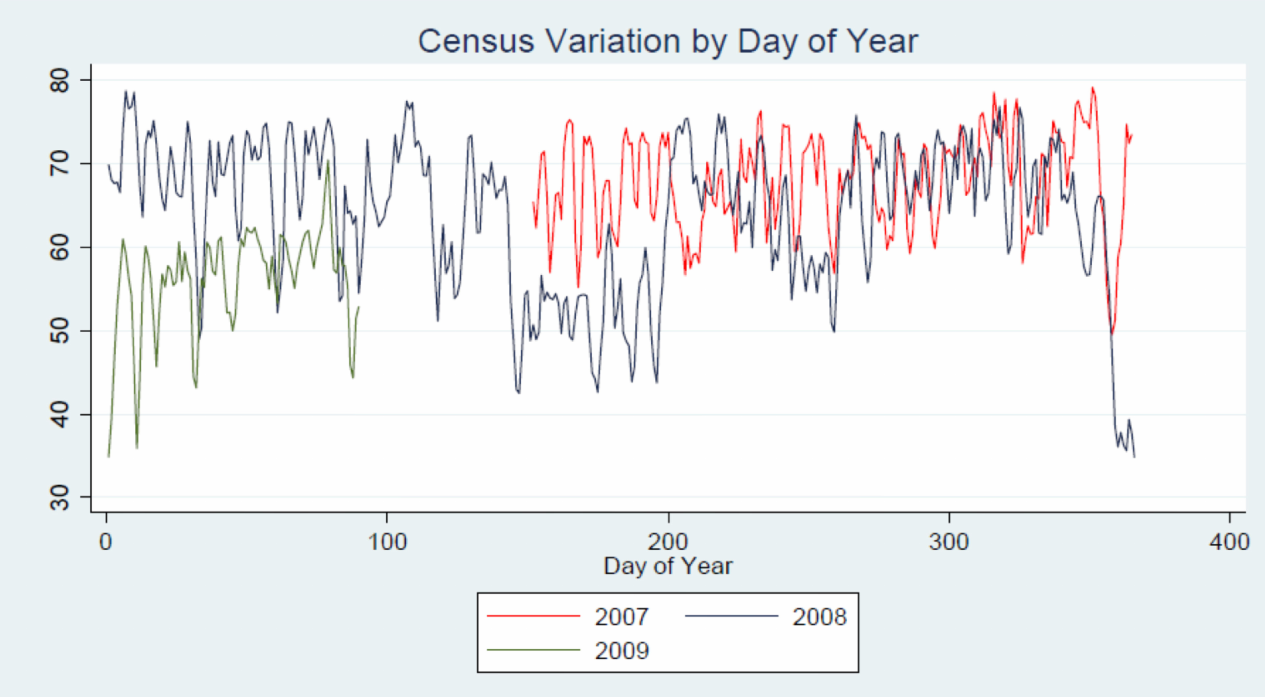
Figure 6. Census fluctuations across four partially interchangeable